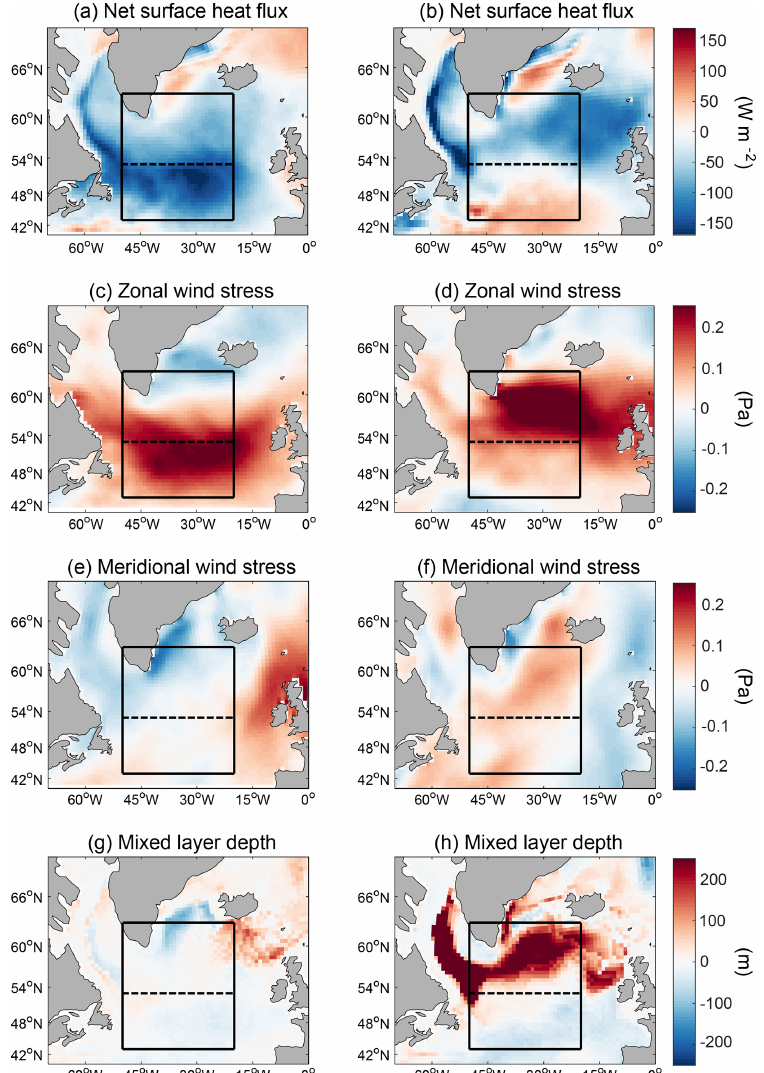
Figure 12. The spatial distribution of ECCOv4-r4 anomalies in the terms causing the initial anomalous surface cooling in Decem- ber 2013 (a, c, e, g) and the same anomalies for January 2015 (b, d, f, h) , when the net heat flux out of the surface ocean was also high but its impact not seen in the temperature of the mixed layer. Shown are anomalies in (a, b) the net surface heat flux (Wm − 2 ), (c, d) zonal wind stress (Pa), (e, f) meridional wind stress (Pa), and (g, h) MLD